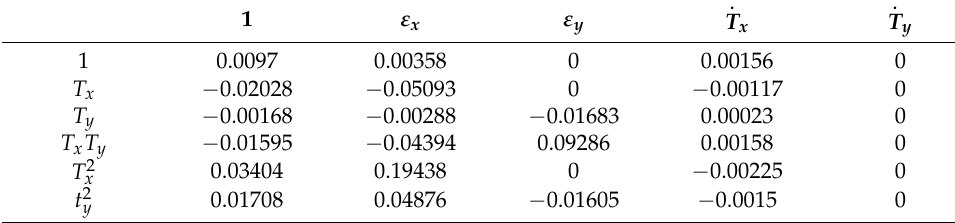
Table 7. Fitting results for (cid:101) D tx , tx .